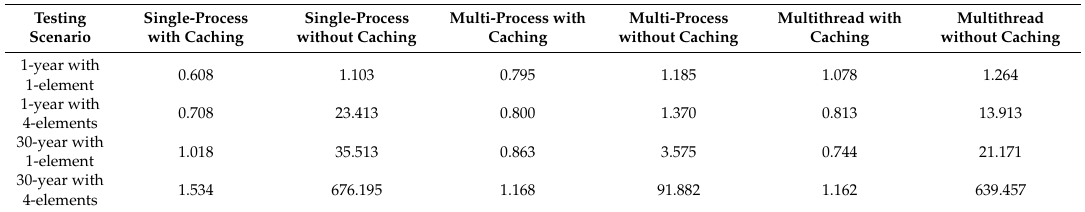
Table 9. Result of the performance